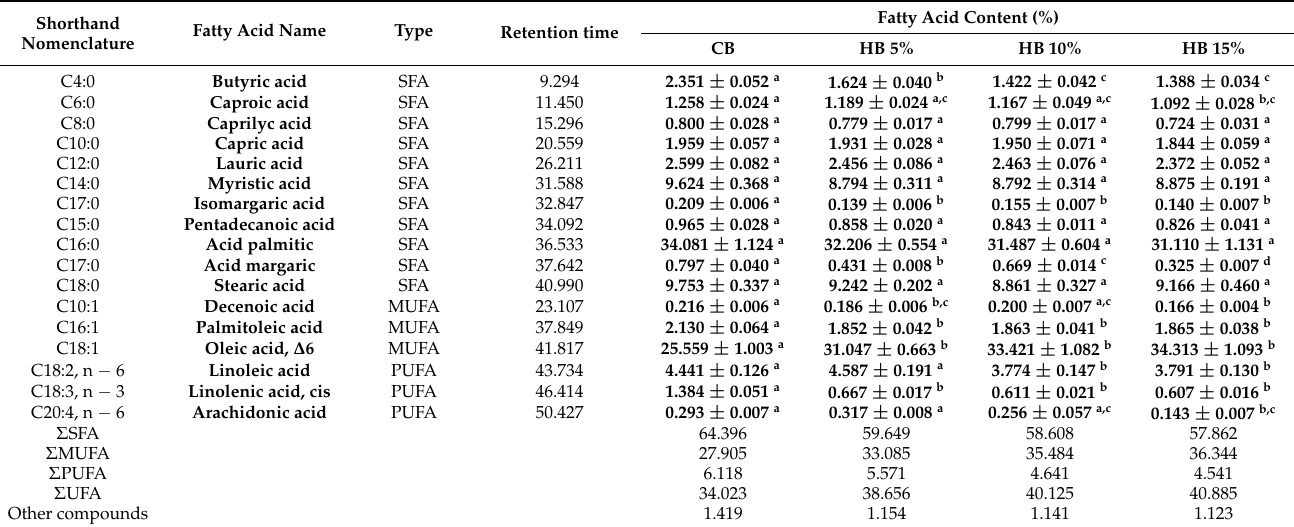
Table 8. Fatty acids composition of biscuit